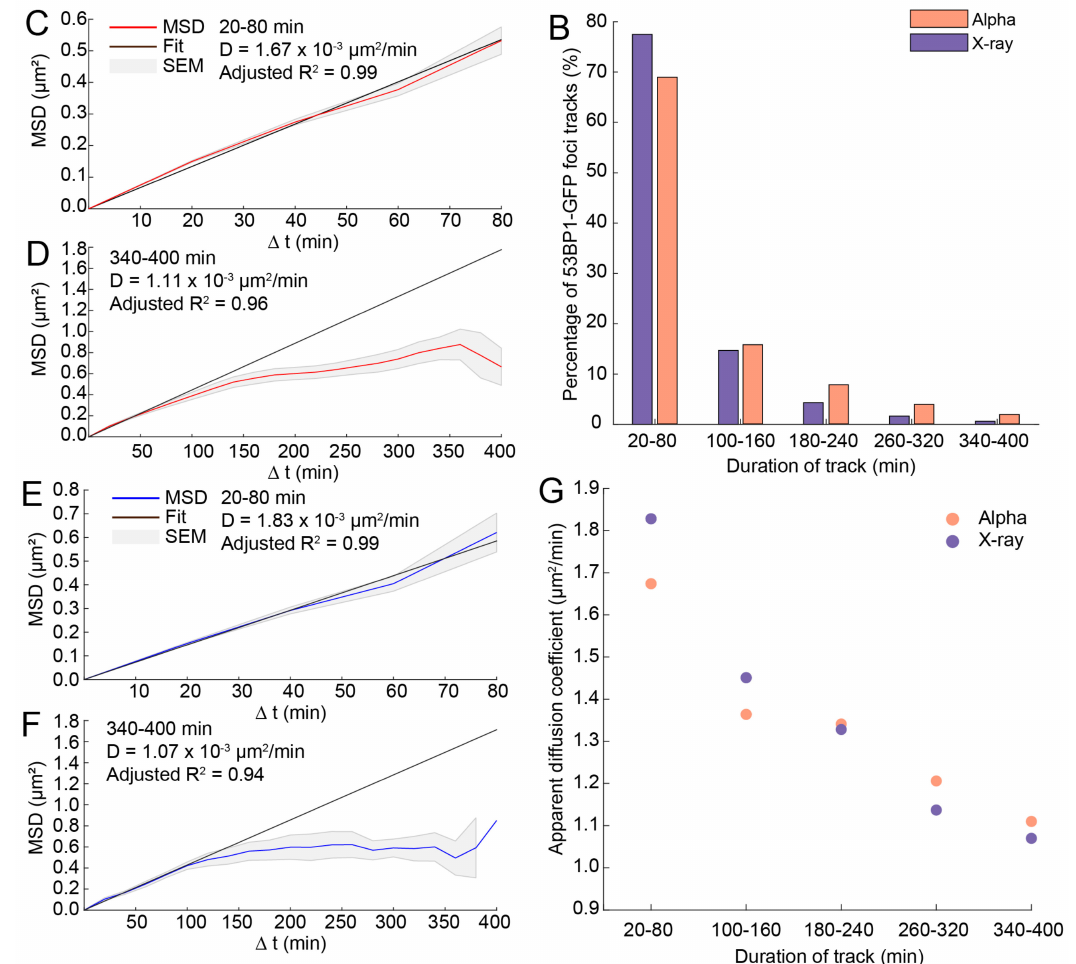
Figure 2. 53BP1-GFP focus resolving after α -particles is slow compared to X-rays. ( A ) Average number of 53BP1-foci per cell over time. Foci in α -particle-irradiated (2 Gy) cells are depicted in red and those in X-ray-irradiated (2 Gy) cells are depicted in blue. All time-points between the indicated bar are significant di ff erences between X-ray- and α -particle-irradiated cells (ANOVA, p < 0.05). Error bars indicate the standard error of the mean (SEM). ( B ) Percentage of detected 53BP1-GFP focus tracks that were present in α -particle-irradiated cells (red) or X-ray-irradiated cells (blue) for indicated time. ( C – F ) Mean square displacement (MSD) curves of the binned track lengths. α -particle-irradiated cells are depicted using a red line ( C , D ) and X-ray-irradiated cells are shown in blue ( E – G ). The average apparent di ff usion coe ffi cient of 53BP1-GFP foci, which was based on the fit on the first four time